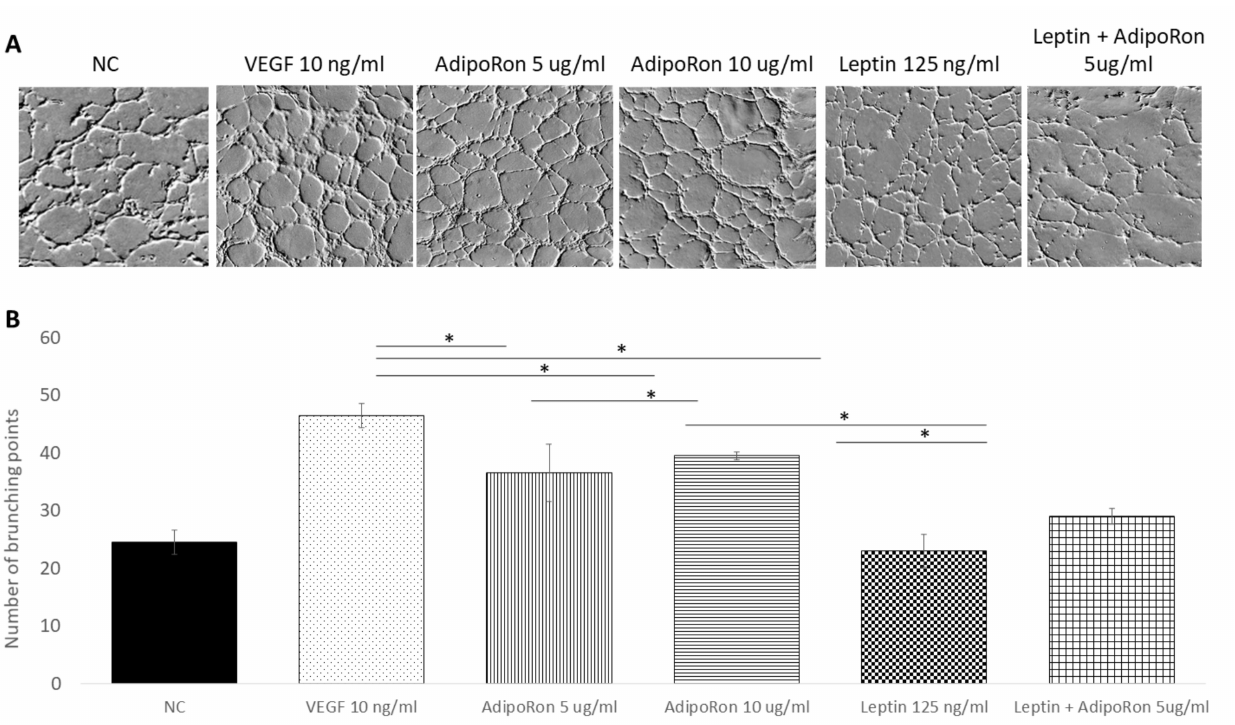
Figure 2. AdipoRon and leptin exert antagonizing effects on tube formation. HUVEC endothelial cells were treated with AdipoRon (5 or 10 µ g/mL), Leptin (125 ng/mL) and a combination of AdipoRon+leptin (5 µ g/mL and 125 ng/mL, respectively) for 4 h. Panel ( A ) shows representative images of tube formation; panel ( B ) show the mean quantitation of complete tubular structures of three independent experiments. Both doses of AdipoRon induced relevant angiogenesis compared to untreated cells. Leptin does not induce angiogenesis; in the combinational treatment, Leptin antagonizes AdipoRon effects. Untreated cells were considered as the negative control; cells treated with VEGF-A (10 ng/mL) was considered as a positive control. Data are reported as mean ± standard deviation (SD) of three independent experiments. * p <